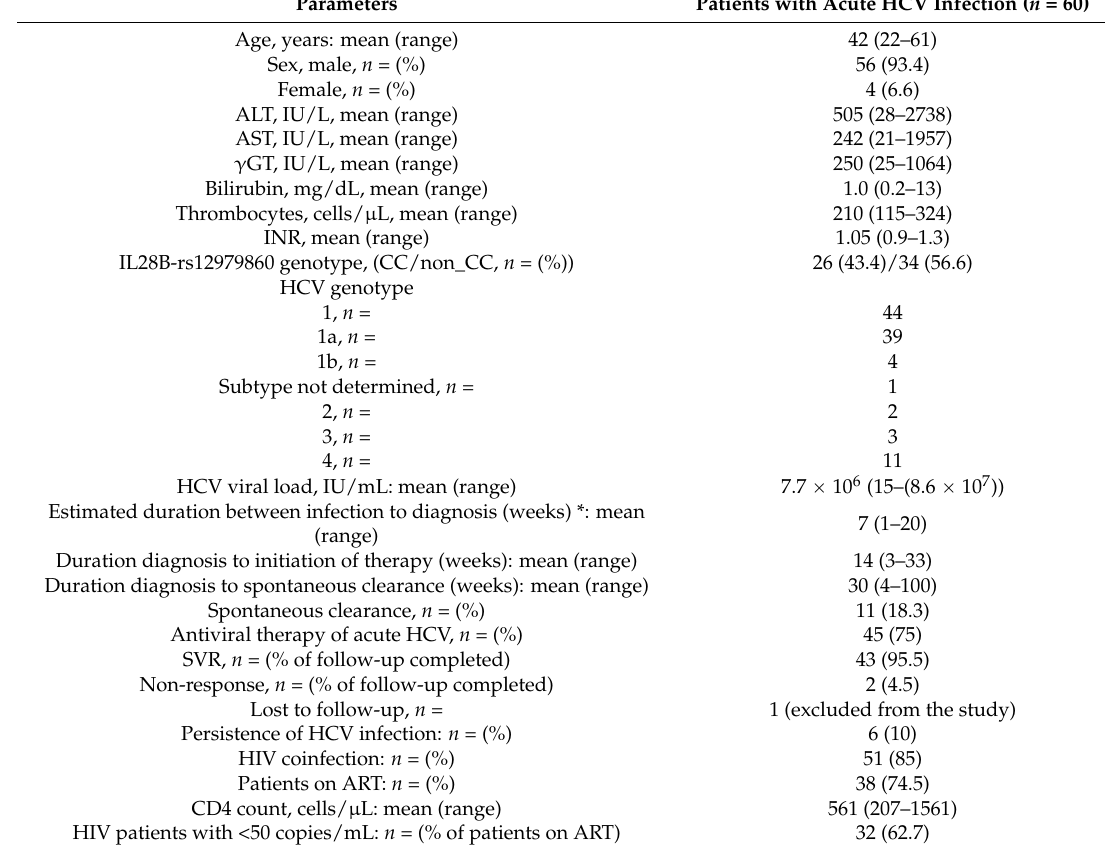
Table 1. Patient’s baseline biochemical and virological